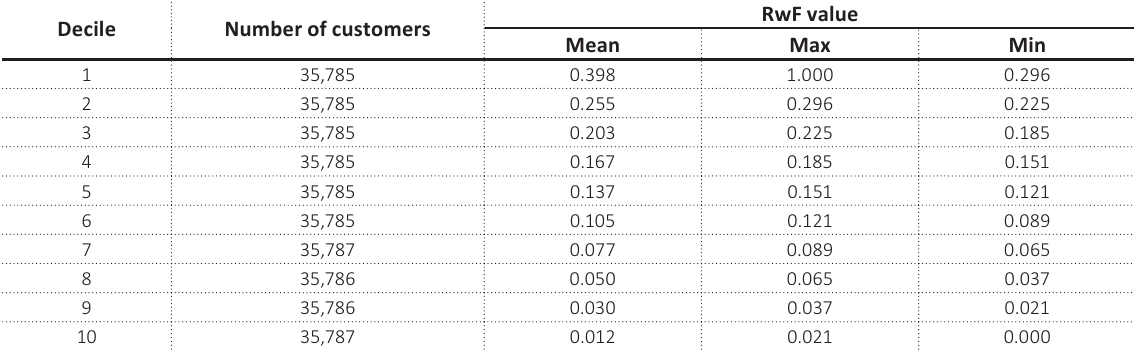
Table 3. RwF values statistics